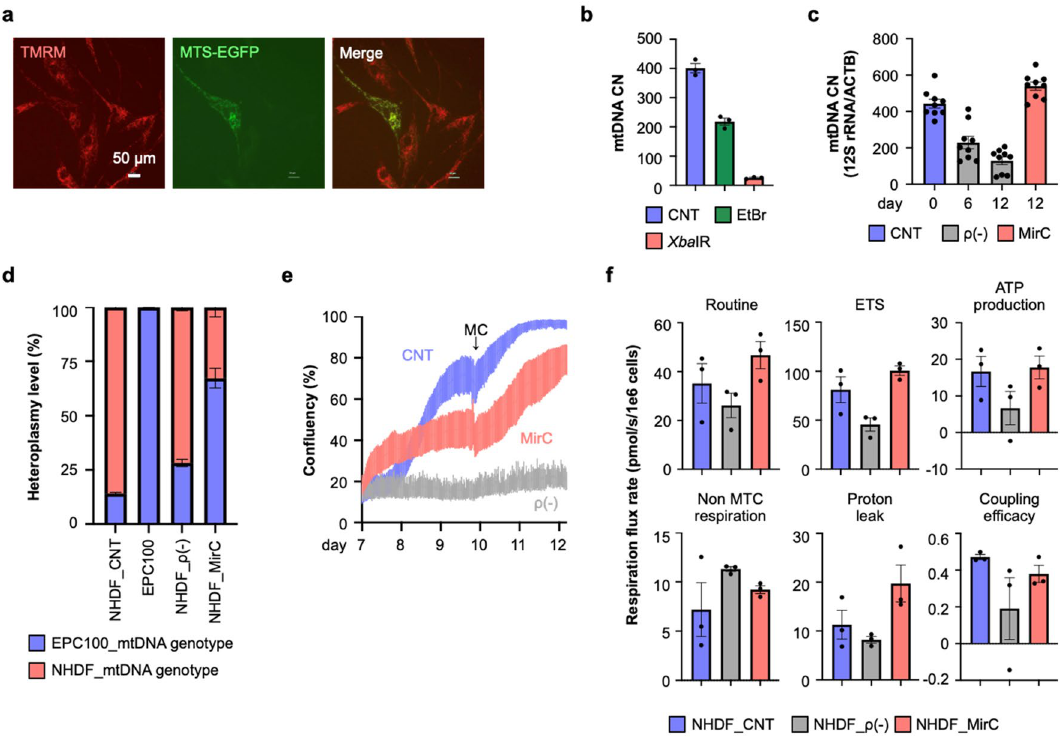
Figure 1. MirCs were generated from normal human dermal fibroblasts (NHDFs). ( a ) Left; TMRM staining specific for mitochondria in NHDFs, Middle; NHDFs, which were transfected with pCAGGS-MTS-EGFP- PuroR and selected with puromycin, reticularly expressed EGFP, Right; EGFP completely merged the red fluorescence of TMRM, verifying that MTS correctly transported downstream genes of interest to mitochondria. White bar indicates 50 µm. ( b ) By qPCR on day 5 following the treatment for mtDNA reduction, the mtDNA copy number (CN) of endonuclease-treated cells was decreased to less than 10%, clearly contrasted with the effect of EtBr treatment. (n = 3, respectively). ( c ) MtDNA CN in MirC increased to baseline levels on day 12 with coincubation of isolated mitochondria. (n = 9, respectively). ( d ) Heteroplasmy in MirCs of NHDFs with exogenous mitochondria showed the domination of exogeneous origin of mtDNA with a minor portion of the endogenous genotype. (n = 3, respectively). ( e ) Although the proliferation of MirCs was lower than that of the parental cells from day 7 to day 10 following mitochondrial DNA replacement, that of MirCs was equivalent to that of the parental cells after day 10, when medium change (MC) was performed. ρ(-) cells proliferated quite slowly throughout all periods. The cell numbers were quantified and plotted by JuLI STAT software based on the area of cells. MC: medium change. ( f ) Key parameters of respirometry were quantified. (n = 3,